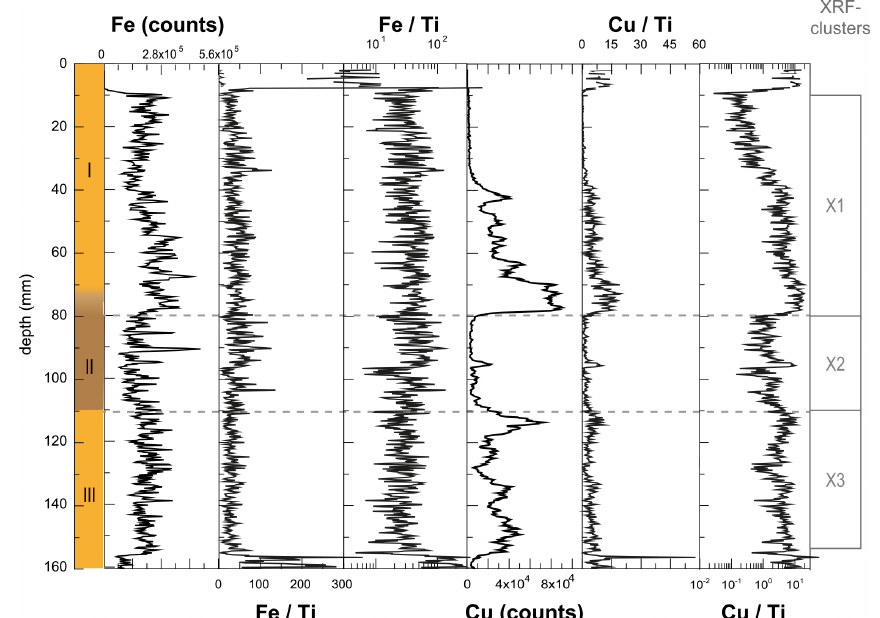
Figure A4. Effect of normalization for minerogenic inputs on the Fe and Cu signals in WMM7. Due to low or absent contributions of Al (Fig. A3), data were normalized to Ti. Fe / Ti and Cu / Ti are shown here for comparison as the original ratios and on a log scale. Fig. 3 presents all normalized XRF data on a linear scale, excluding 0–10 and 155–160mm, where very low counts of one or more element lead to anomalous